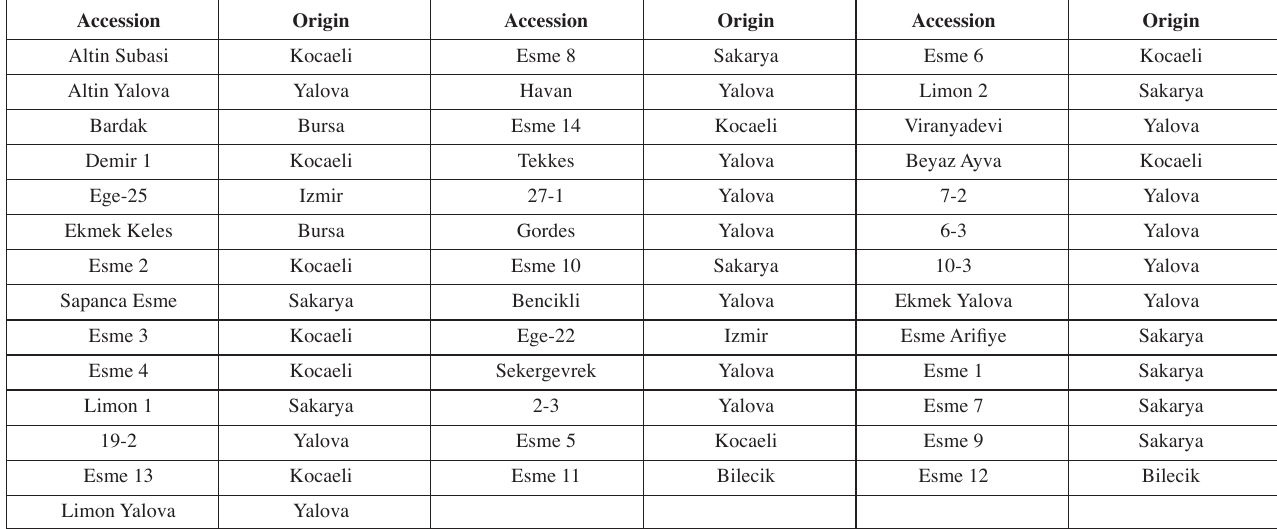
Tab 1: The origin of quince accessions used in this study